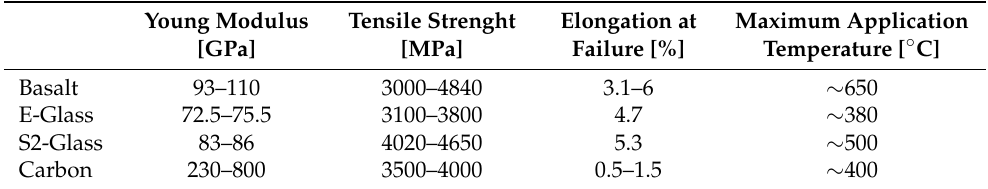
Table 1. Comparison of basalt fiber properties to other types of fibers commonly used as polymer matrix reinforcement [3]. Young Modulus Tensile Strenght Elongation at Maximum Application [GPa] [MPa] Failure [%] Temperature [ ◦ C] Basalt 93–110 3000–4840 3.1–6 ∼